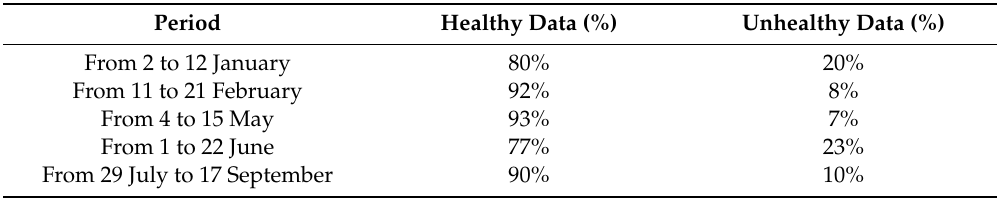
Table 2. Ratio between healthy and unhealthy data for every